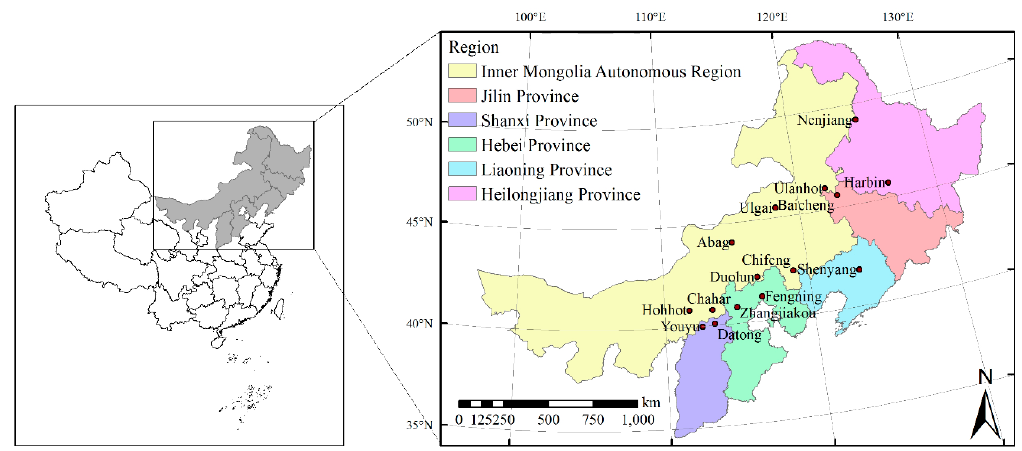
Figure 1. Main planting areas of oat in North and Northeast China.